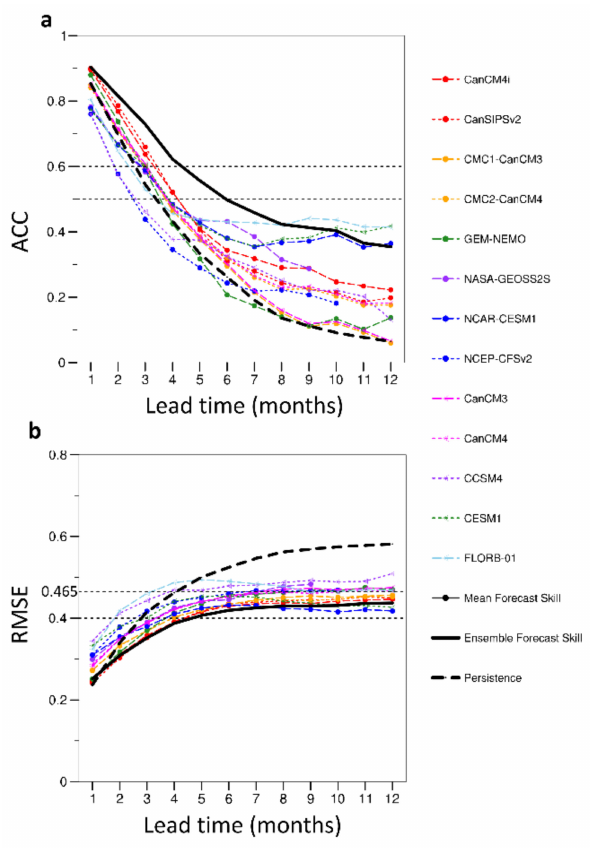
Figure 2. ( a ) Anomaly correlation coefficient (ACC, vertical axis) of Atl3 index between the obser- vation and 13-model forecast results with respect to the lead time (horizontal axis; unit: months). The black solid curve is the NMME multi-model ensemble (MME) forecast result, the dashed black curve denotes the persistence, and the colored dotted curves denote the individual models as shown in the legend. ( b ) same as ( a ), but for the root-mean-square error (RMSE, vertical axis) of Atl3 index. Auxiliary lines in ( b ) are 0.465 (one STD of the observed Atl3 index equals to 0.465) and 0.4,